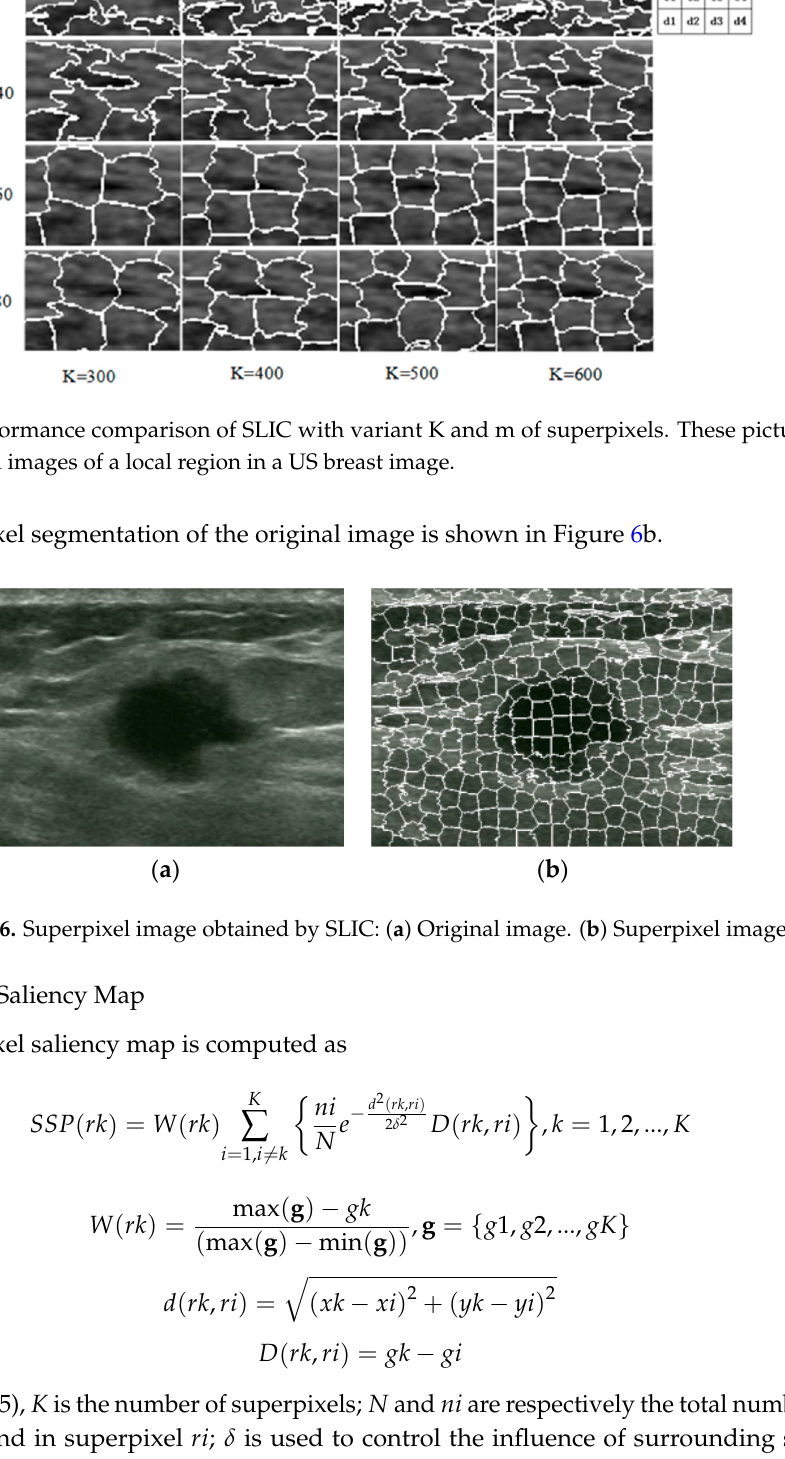
Figure 4. Input image of SLIC network.